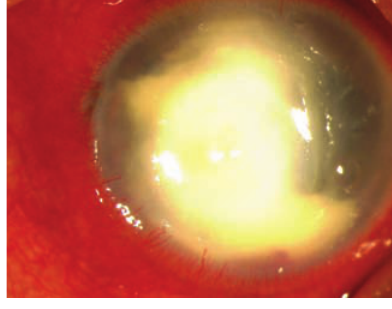
1. Clinical photo of Lasiodiplodia theobromae